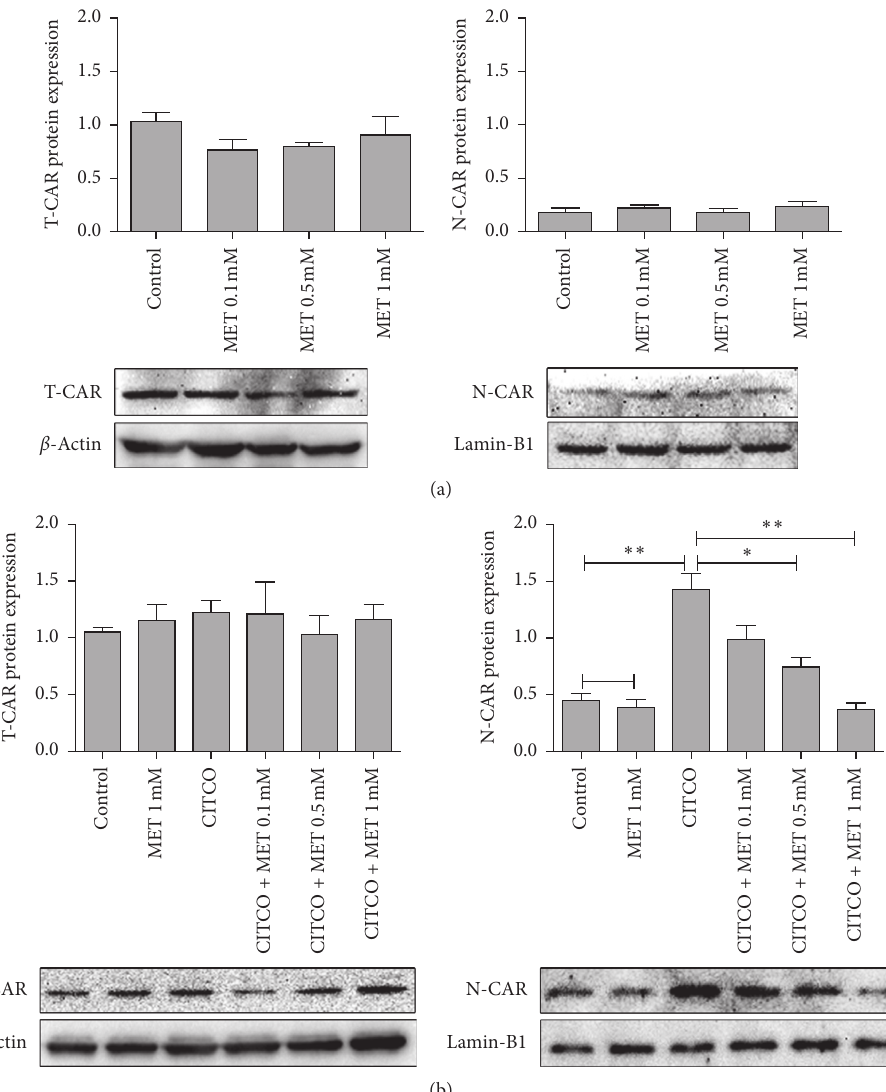
Figure 3: The effects of metformin with or without CITCO on CAR protein expression. HepaRG cells were treated with metformin (0.1, 0.5, 1mM) (a) and CITCO (1 μ M) (b) either individually or in combination for 48h. Cells treated only with DMSO were considered as the control group. Total cell proteins and the nuclear proteins were harvested, respectively. Protein levels were determined by western blotting and were quantified with Image J. Quantitation of the T-CAR protein bands was normalized to β -actin; quantitation of the N-CAR protein bands was normalized to lamin-B1. The data shown are the mean ± SEM ( n � 3) ( ∗ P < 0 . 05 and ∗∗ P < 0 . 01, comparison indicated by brackets. ns: not